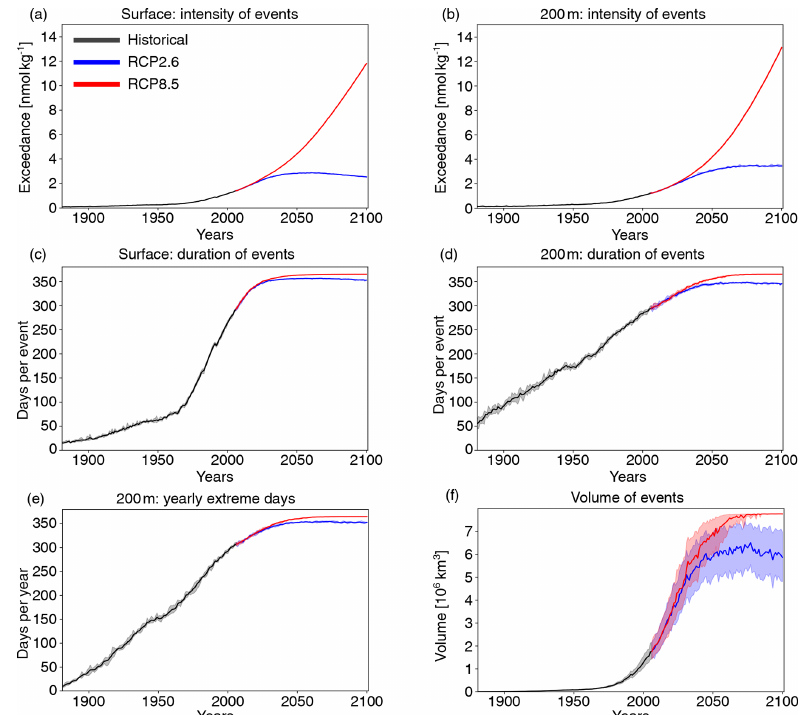
Figure A1. Simulated globally averaged changes in [H + ] extreme events defined with respect to the fixed preindustrial baseline. Shown are changes over the 1861–2100 period following historical (black lines) and future RCP8.5 (red) and RCP2.6 (blue) scenarios for maximal intensity at the surface (a) and at 200m (b) , duration at the surface (c) and at 200m (d) , yearly extreme days at 200m (e) , and volume in the upper 200m (f) . The thick lines display the five-member ensemble means, and the shaded areas represent the maximum and minimum ranges of the individual ensemble members.